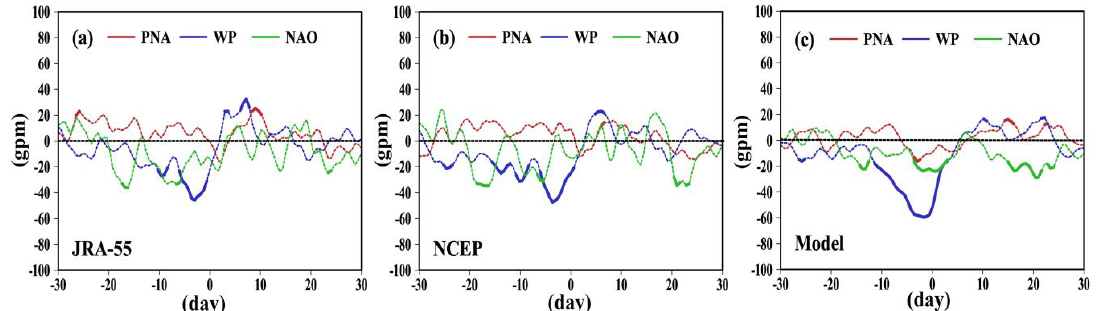
Figure 8. Day-to-day evolution of the PNA ( red ), WP ( blue ), and NAO ( green ) indices from day − 30 to day 30 from ( a ) the JRA55 reanalysis, ( b ) the NCEP / NCAR reanalysis, and ( c ) CESM1-WACCM. Thickened solid parts of the line indicate that the composite index is significant at the 95% confidence level according to the t -test.